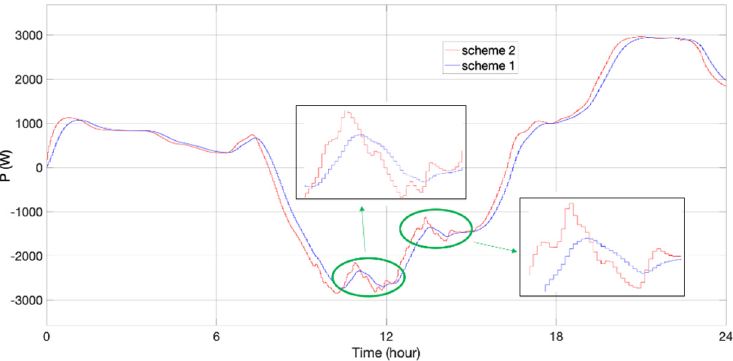
Figure 23. LiBs assumed power comparison.